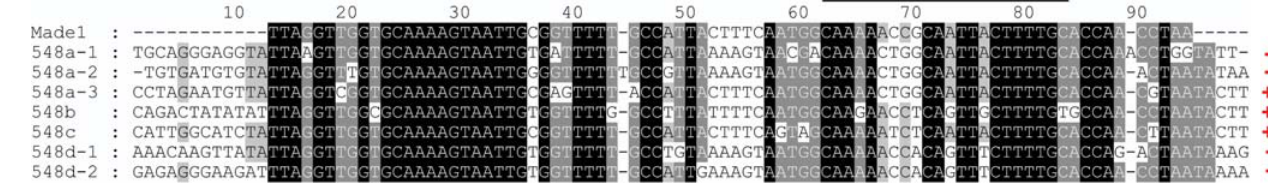
Figure 1. Multiple sequence alignment of Made1 and hsa-mir-548 genes. The location of the mature miRNA sequence is indicated by the bar over the alignment. The strand of the Made1 element ( + / 2 ) from which the miRNA genes are derived is shown to the right of the